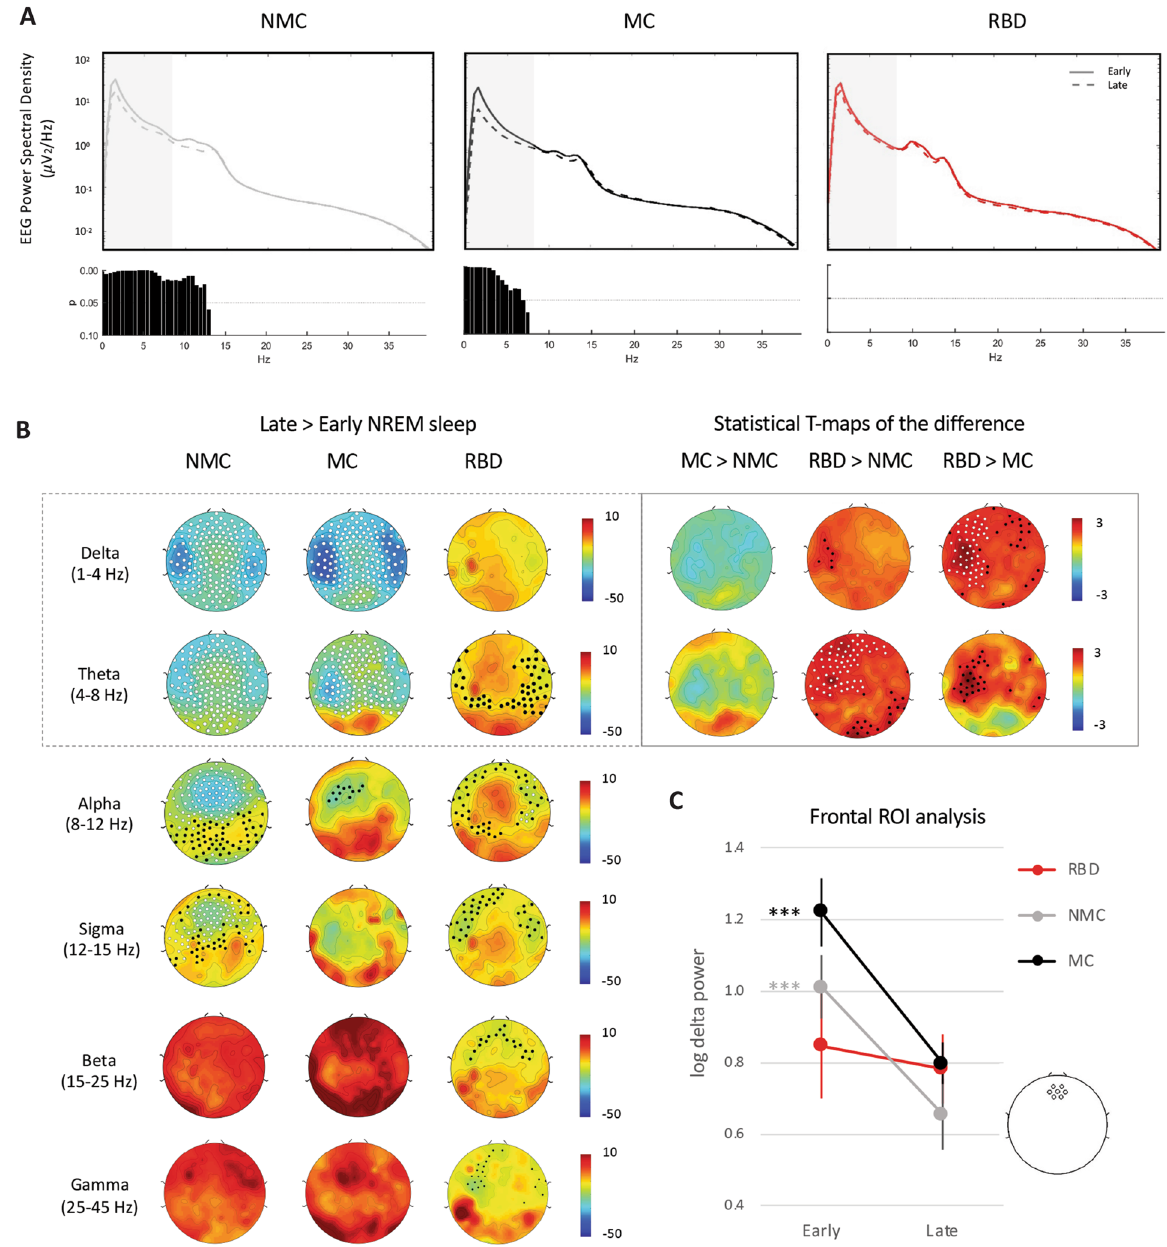
Figure 2. Delta and theta power as NREM sleep homeostasis markers in RBD patients and controls. ( A ) Global EEG power spectra in NREM sleep from the first cycle (continuous line) and last cycle (dashed line) in the three groups. FDR-corrected P values from paired t-tests for the comparison between states within groups are shown below each plot, respectively. Greyed areas represent the delta/SWA and theta band. ( B ) Normalized change in log power between the last and first cycle of NREM sleep in delta/SWA (1–4 Hz) and theta (4–8 Hz) in non-medicated controls (left), medicated controls (middle) and patients (right). Left columns: White dots indicate p < 0.05 and black dots p < 0.1 after SNPM correction for one sample t-test on the change. Statistics on the changes showed significant differences between groups in the delta and theta range only and are shown in the right insert. Individual channel t-maps are represented, with white dots indicating channels with SNPM corrected p < 0.05 and black dots uncorrected p < 0.05 after unpaired t-tests on the late to early NREM power difference. ( C ) ROI analysis for change in frontal absolute delta power/SWA between early and late night. Frontal ROI was centered around Fz and consisted of seven electrodes (see insert). The expected decrease in absolute delta power/SWA is visible in both control groups but not in patients. Repeated-measure ANOVA with “group” and “time” revealed a significant interaction ( p = 0.012). *** p < 0.001 Tukey Kramer post-hoc test between “early” and “late”. The frontal delta power during the first cycle in RBD patients appeared lower compared to medicated controls at a trend level ( p =